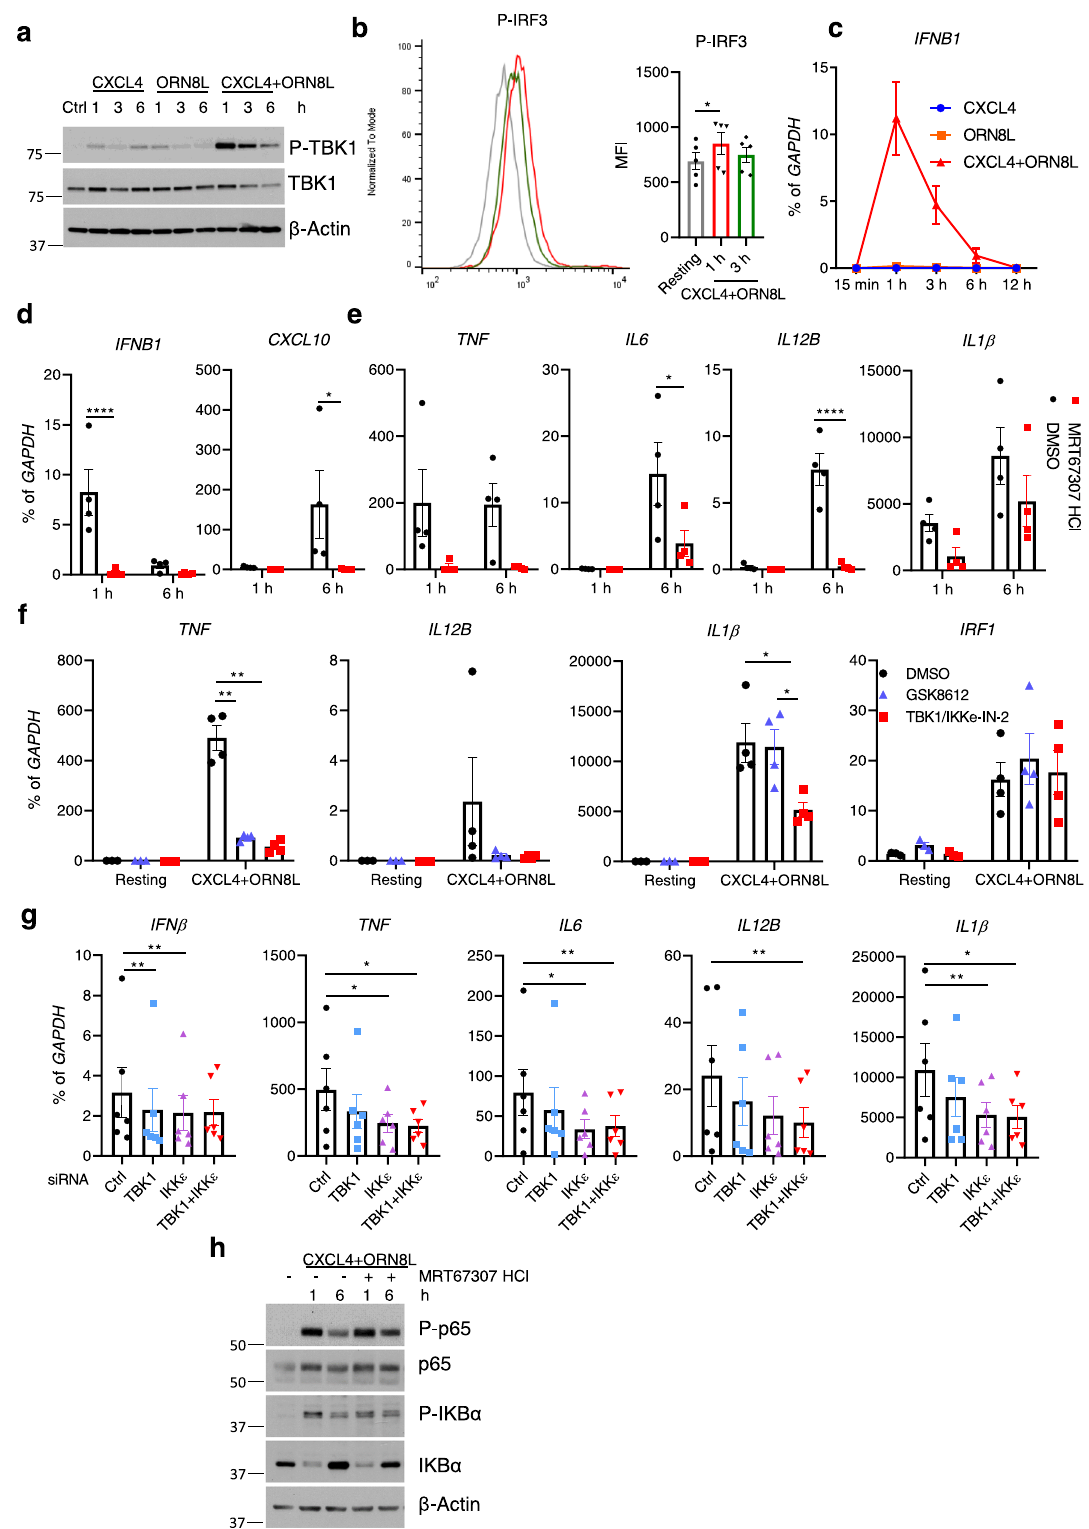
TLR8 strongly and signi fi cantly induced occupancy of NF- κ B Supplementary Fig. 10b – e. TOBIAS footprinting analysis revealed and IRF motifs, and also of STAT1:STAT2 and STAT1 motifs that CXCL4 strongly and signi fi cantly induced occupancy of (the IRF and STAT binding is consistent with the known TLR- NF- K B and AP-1 motifs; in addition to canonical Fos and Jun induced type I IFN autocrine loop) 59,60 . These results implicate family AP-1 proteins, the footprinted sequences show binding by the BATF, BATF3, and BACH2 members of the extended AP-1 NF- κ B, AP-1, and IRF TFs in mediating chromatin remodeling family (Fig. 4g and Supplementary Data 1). In contrast, and gene expression induced by CXCL4 and TLR8, with NF- κ B NATURE COMMUNICATIONS| (2022) 13:3426 |https://doi.org/10.1038/s41467-022-31132-7|www.nature.com/naturecommunications